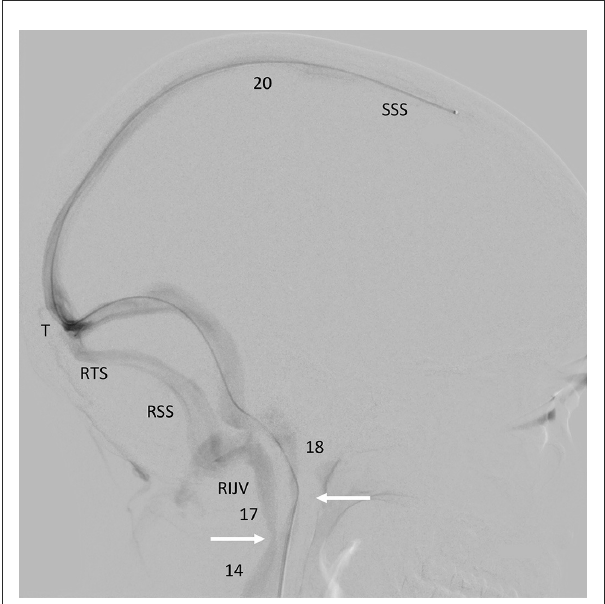
FIGURE2 Catheter venogram. Background-subtracted, oblique lateral view of the head and upper neck. Radiographic contrast injected through a catheter passed up through the left lateral sinus into the sagittal sinus outlines the sagittal, both lateral sinuses and upper jugular veins. There is a narrowing of both internal jugular veins (arrows) where they pass over the transverse processes of C1 (SSS, superior sagittal sinus; T, torcula; RTS, right transverse sinus; RSS, right sigmoid sinus; RIJV, right internal jugular vein) (Numbers = pressure recordings in cm H 2